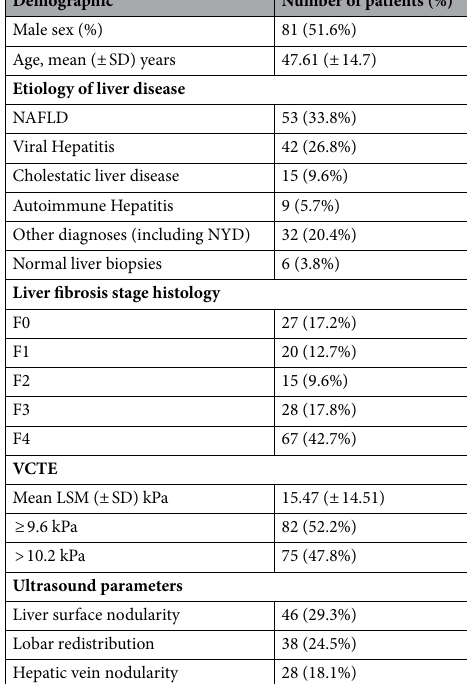
Table 1. Demographic and clinical characteristics of the study cohort. kPa, kilo pascal; LSM, liver stiffness measurement; NAFLD, non-alcoholic fatty liver disease; NYD, not yet determined; SD, standard deviation; VCTE, vibration controlled transient elastography.